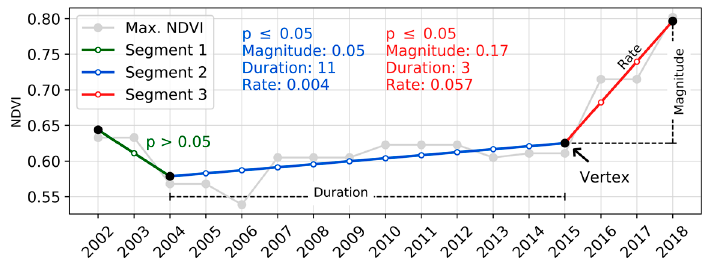
Figure A3. Interpretation of the nature of changes in ecosystem functioning based on the spatial agreement of vegetation (NDVI) and rainfall trends. A decrease in NDVI despite an increase in precipitation or vice versa is likely to be caused by human management. Trend combinations with the same slope direction are likely to be caused by climate change [26].